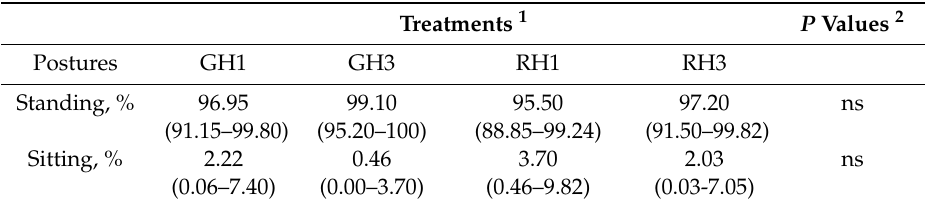
Table 8. Back-transformed least squares means (confidence limits) of postures observed during transport according to the handling type and number of laps in the handling